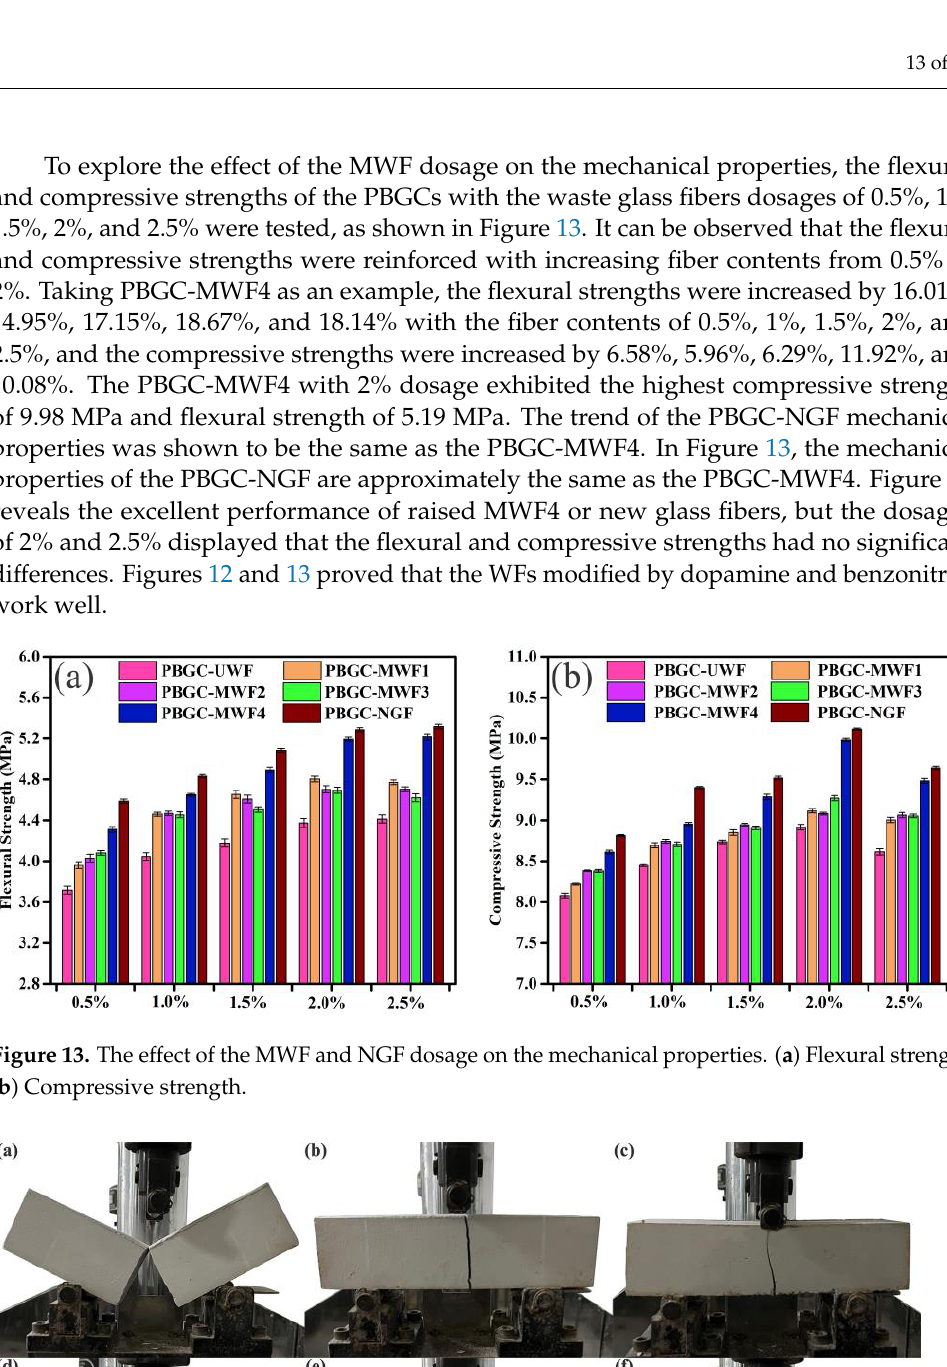
Figure 12. Effects of the different MWF and NGF on the mechanical properties at fixed WF contents of 1.0 %. ( a ) Flexural strength; ( b ) Compressive strength.